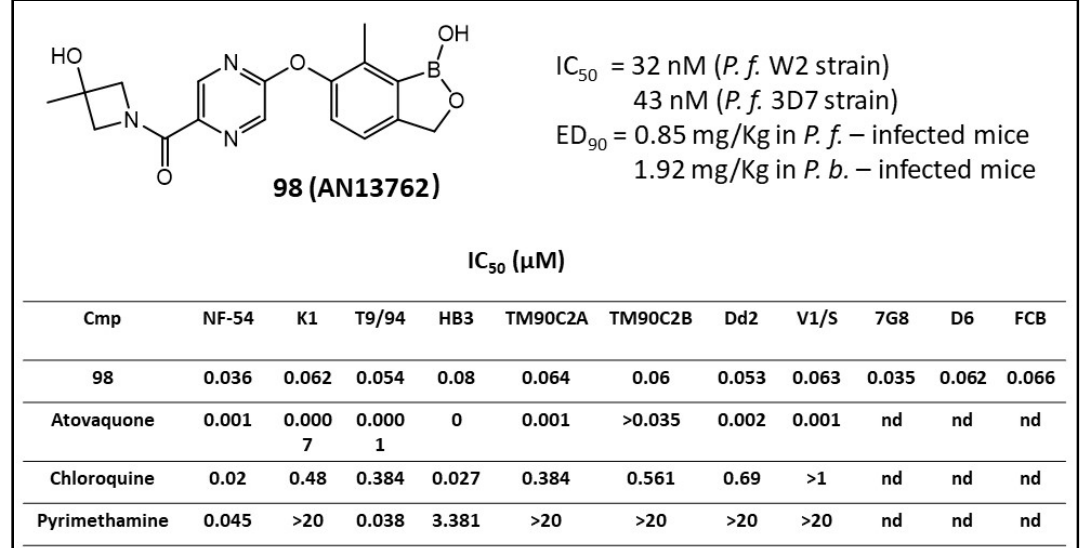
Figure 8. In vitro activities of 98 against multiple P. falciparum parasite strains (IC 50 ) (Adapted from [86]).